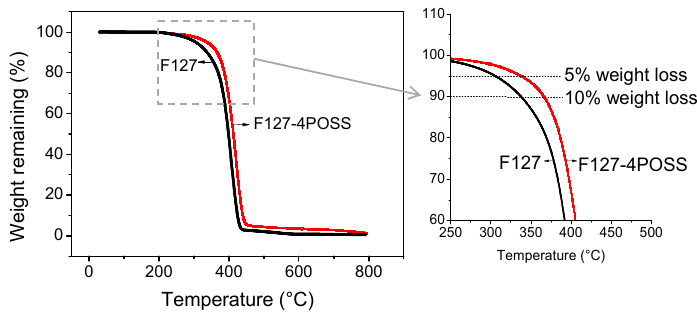
Figure 2. Thermal decomposition analysis of F127 and F127-POSS by TGA.